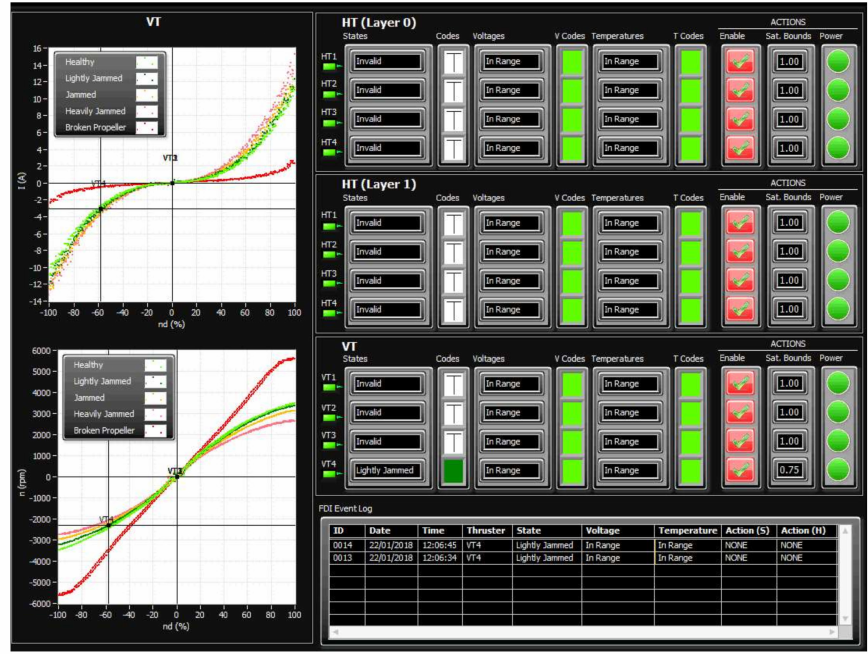
Figure 17. Thruster FDI result for thruster state = “Lightly Jammed”.